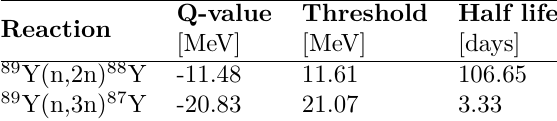
Table 1. Basic reaction parameters relevant for acti- vation technique assessment.